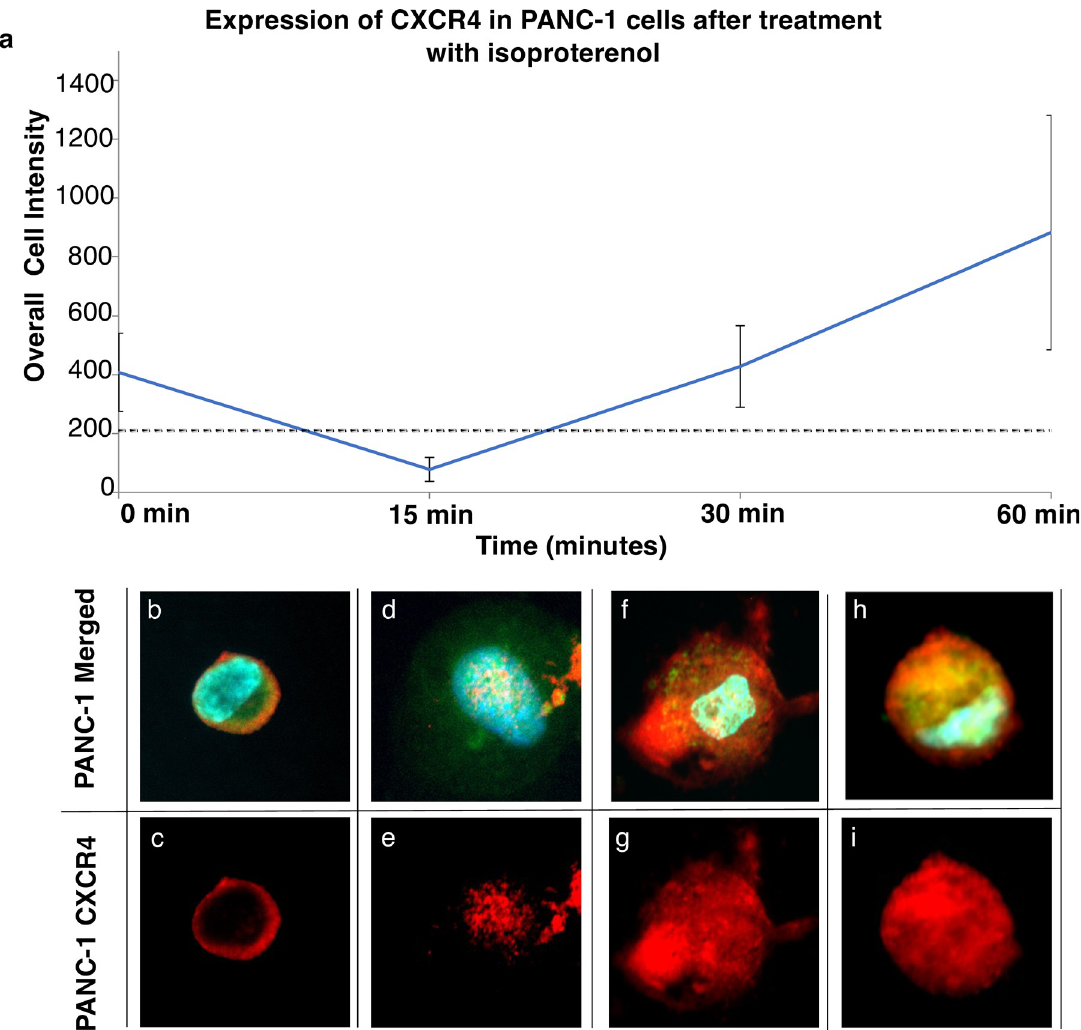
Fig 2. CXCR4 intensity changes, internalization and upregulation in PANC-1 cells after exposure to isoproterenol. a. Intensities of CXCR4 in PANC-1 cell lines compared to exposure times using 20 μ m isoproterenol. Black dotted line ~2x standard deviation (Intensity = 210). Error bars = Standard Error. b & c. Inactive CXCR4 is localized to the perimeter of the cell surface. d & e. In presence of 15 min of isoproterenol, CXCR4 internalizes into endocytic compartments within the cells, causing a lowering of overall signal intensity. f & g. After 30 min, the CXCR4 can be seen within endocytic compartments, on the cell surface, and with increasing signal, as CXCR4 begins recycling to the surface. h & i. Cells increase CXCR4 production in response to high stimuli. b, d, f & h. Merged cell images with DAPI (blue), cytoplasm stain (green), and CXCR4 (red). Boxes = 45 μ